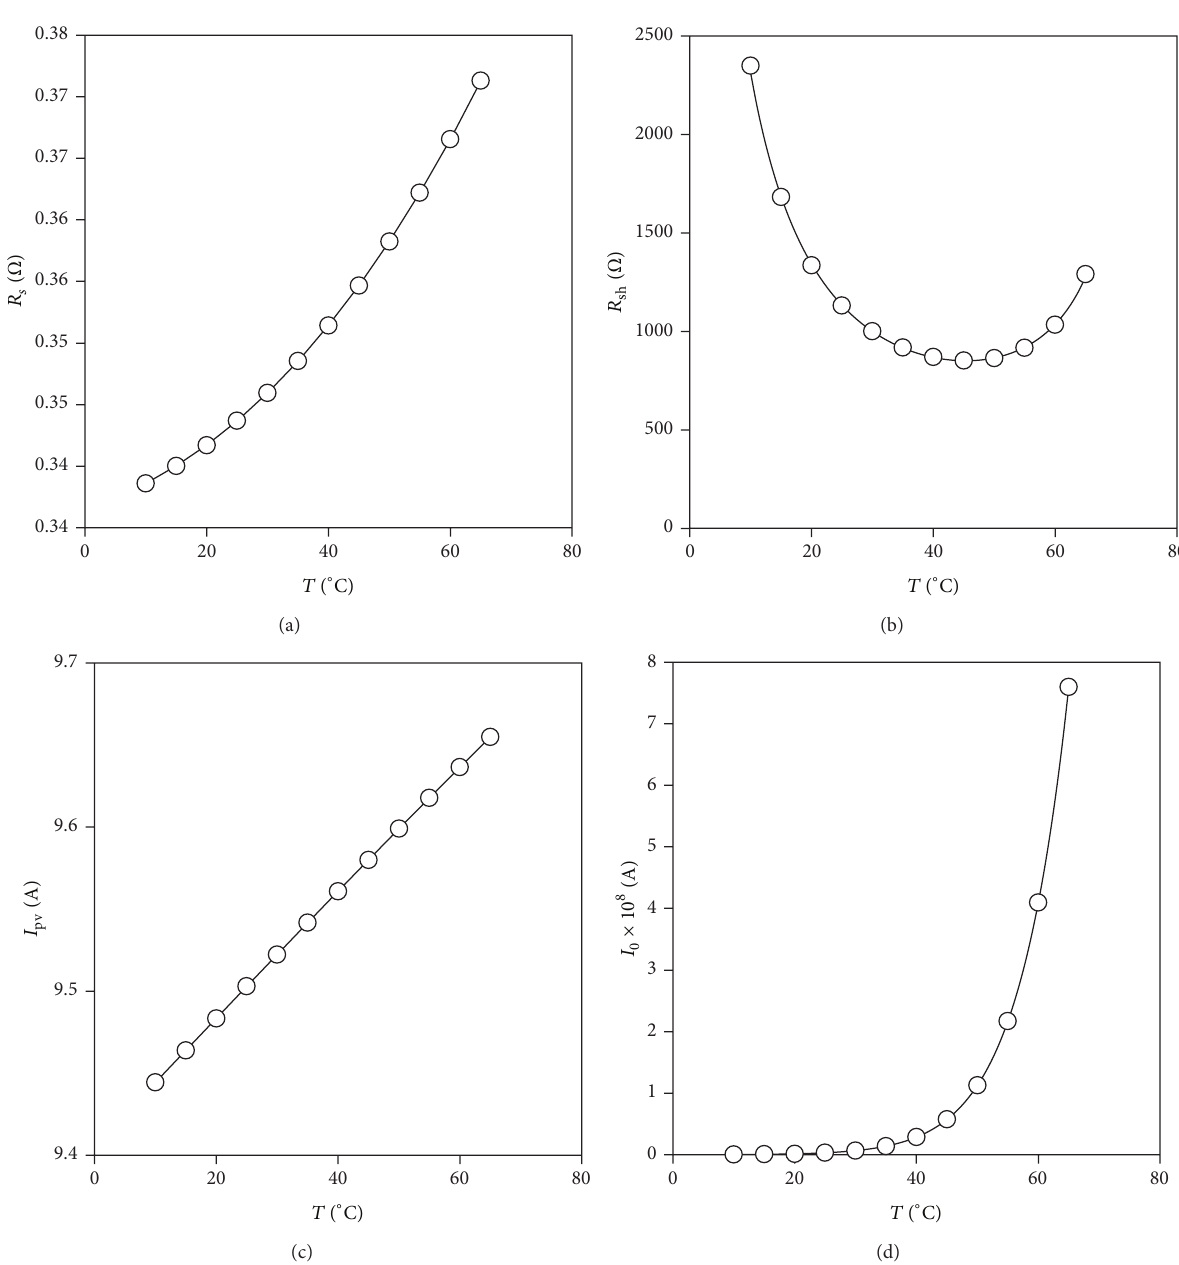
Figure 4: Calculated values of the equivalent circuit parameters 𝑅 𝑠 , 𝑅 the temperature, 𝑇 . Calculated points are indicated with symbols whereas the polynomial approximations fitted to those data (10) have been included in each case as solid